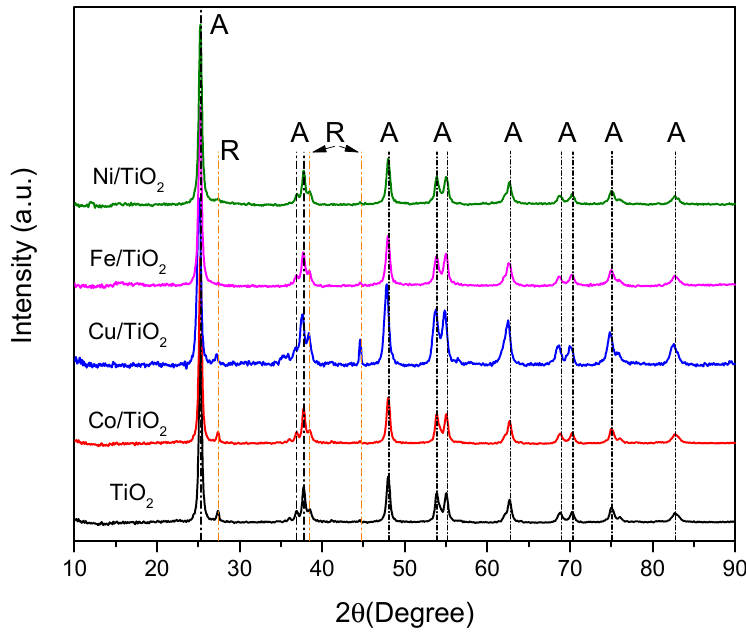
Figure 5. X-ray diffraction patterns of photocatalysts.